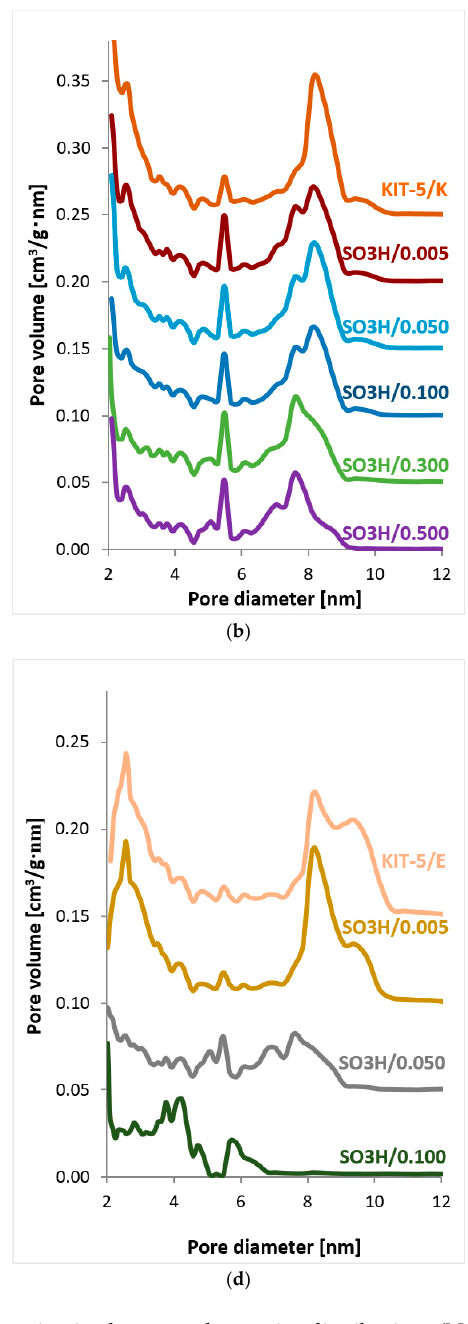
Figure 3. Low-temperature nitrogen sorption isotherms and pore size distributions (N 2 at 77 K on the silica–cylindrical/spherical pore, NLDFT ads. model) for KIT-5 type materials modified with sulfonic groups by ( a , b ) grafting or ( c , d ) co-condensation. The isotherms were shifted by 100 cm 3 /g STP, whereas the pore size distribution curves were 0.05 cm 3 /g·nm for both types of materials.